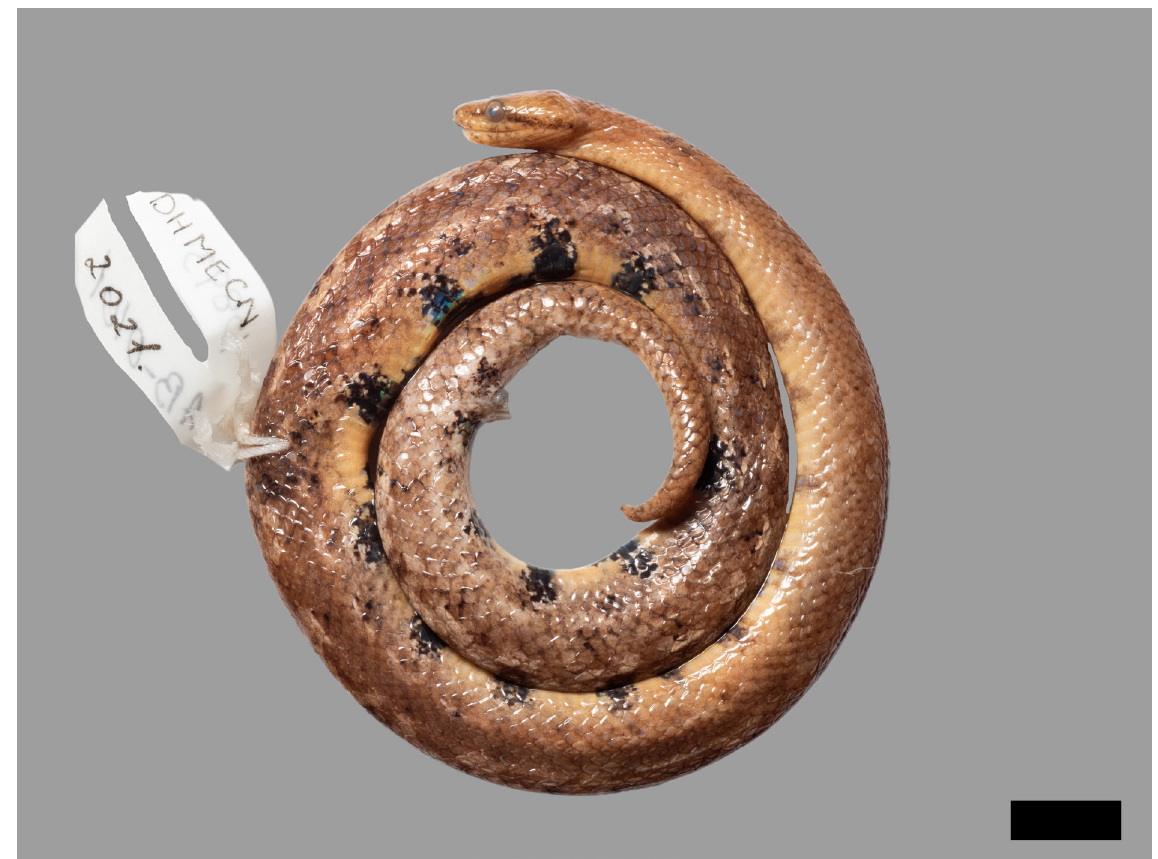
Fig. 4. Lateral view of Tropidophis cacuangoae sp. nov., ♂, holotype (DHMECN 16725). Scale bar = 10